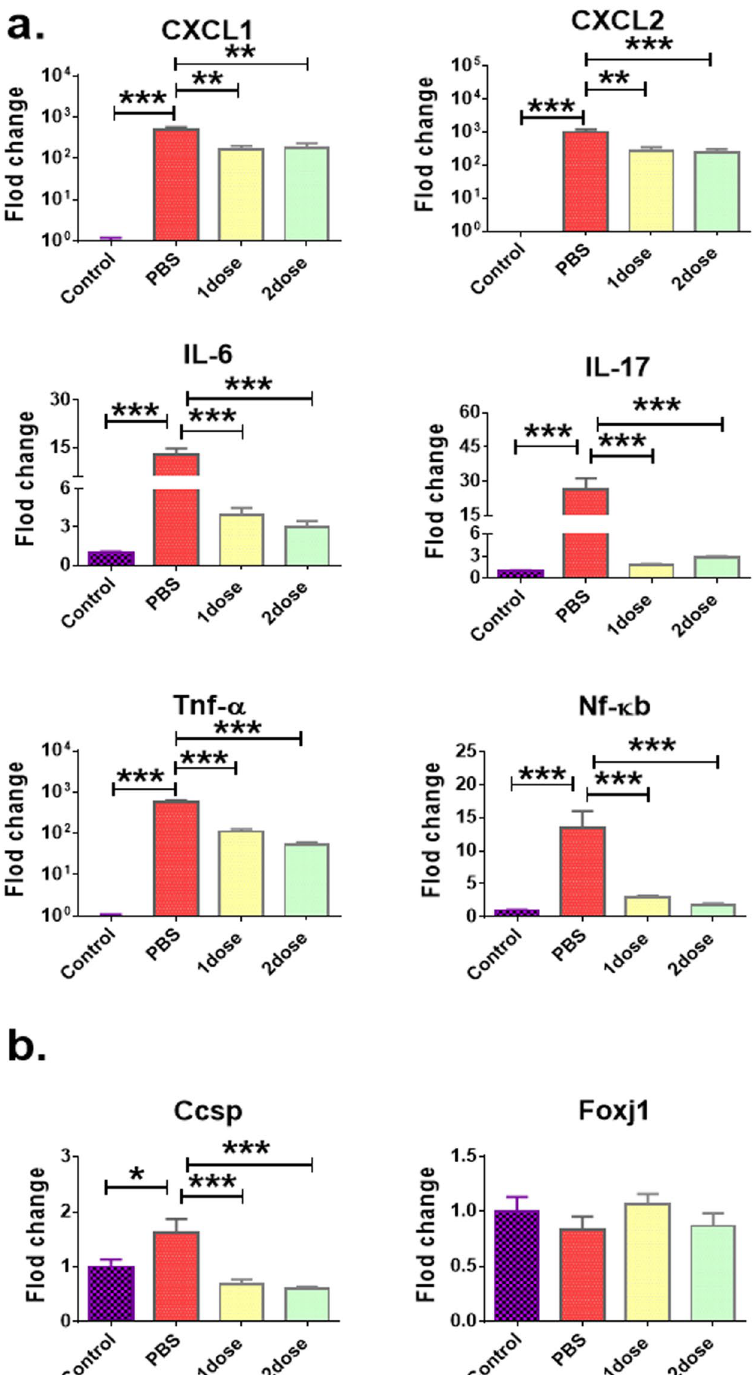
Figure 6. Effect of Esc(1–21)-1c on the expression level of different inflammatory-related genes (panel a) and airway epithelial-associated genes (panel b). Gene expression in the lungs of P . aeruginosa infected mice after a single or a double peptide administration (at 0.1 mg/kg) was investigated at 24 hours after bacterial infection. Mice were intra-tracheally infected with 3 million PAO1 cells. The peptides were administered intra- tracheally at 2 μ g (0.1 mg/kg) at 2 hours and 12 hours after the infection. After 24 hours from bacterial challenge, the RNA was extracted from the lung tissue and quantitative PCR was performed as described 54 . Results are mean ± SEM from three independent experiments; n = 4–6 mice for each treatment group. The t-test was used to compare the means of PBS-receiving non-infected mice (control) versus PBS-treated infected animals. One- way analysis of variance (ANOVA) was used peptide-treated infected mice and PBS-treated infected animals, posthoc comparisons were made using the Dunnett’s multiple comparison test when the P-value was significant ( p < 0.05). * p < 0.05, ** p < 0.01, *** p < 0.001 for peptide-treated infected mice or PBS-receiving non-infected mice (control) versus PBS-treated infected